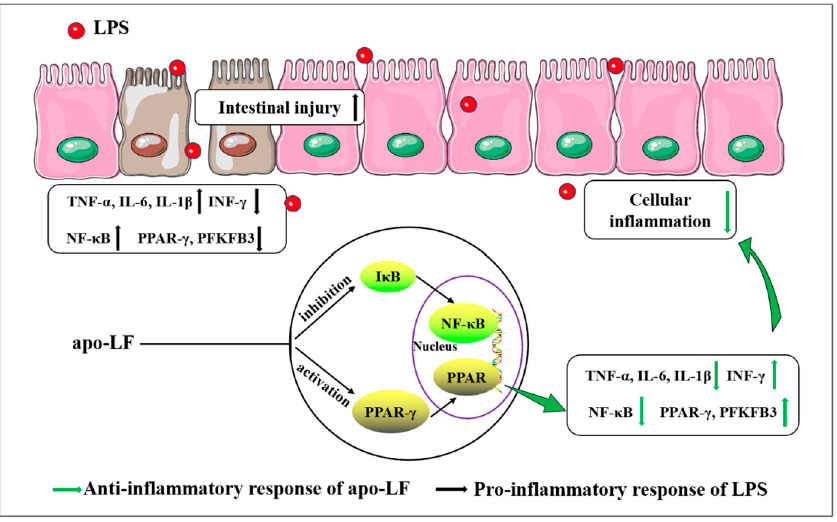
Figure 6. Mechanism diagram of the protective effect of apo-LF on LPS-induced intestinal inflammatory injury.